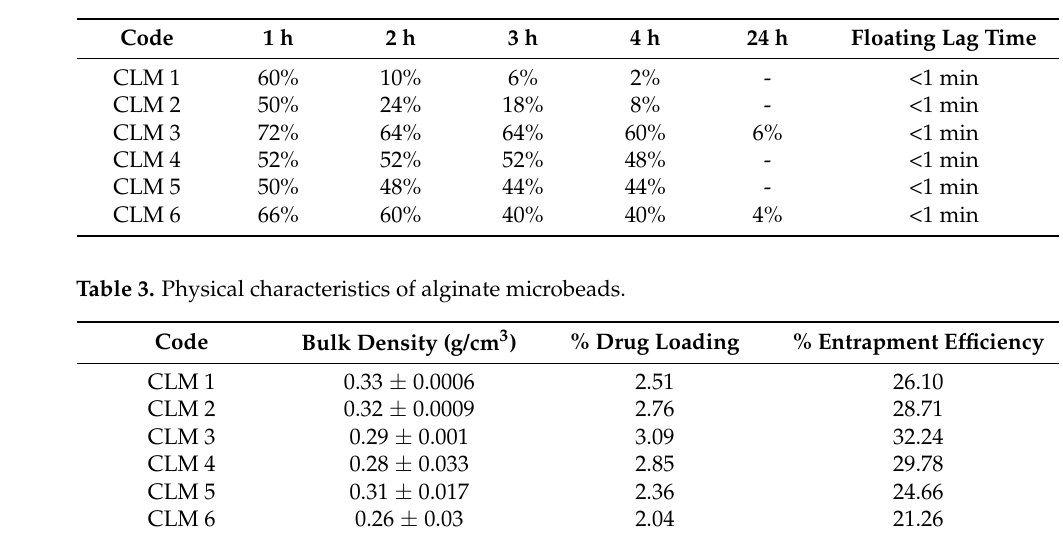
Table 2. % Floating at different time intervals and floating lag time of all formulations.